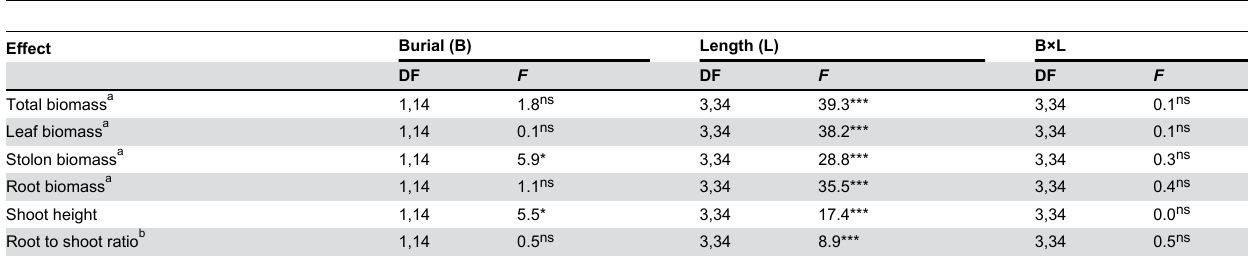
Table 2. Split-plot ANOVAs for effects of burial depth, stolon internode length and the interaction on growth and morphological characteristics of Mikania micrantha .